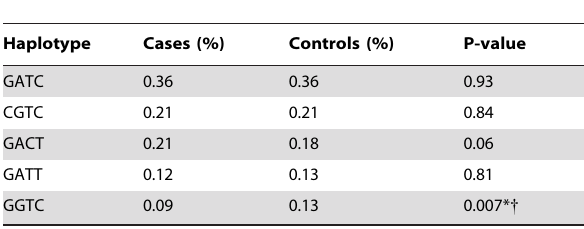
Table 6. Associations between CYP4F2 haplotypes and CD.